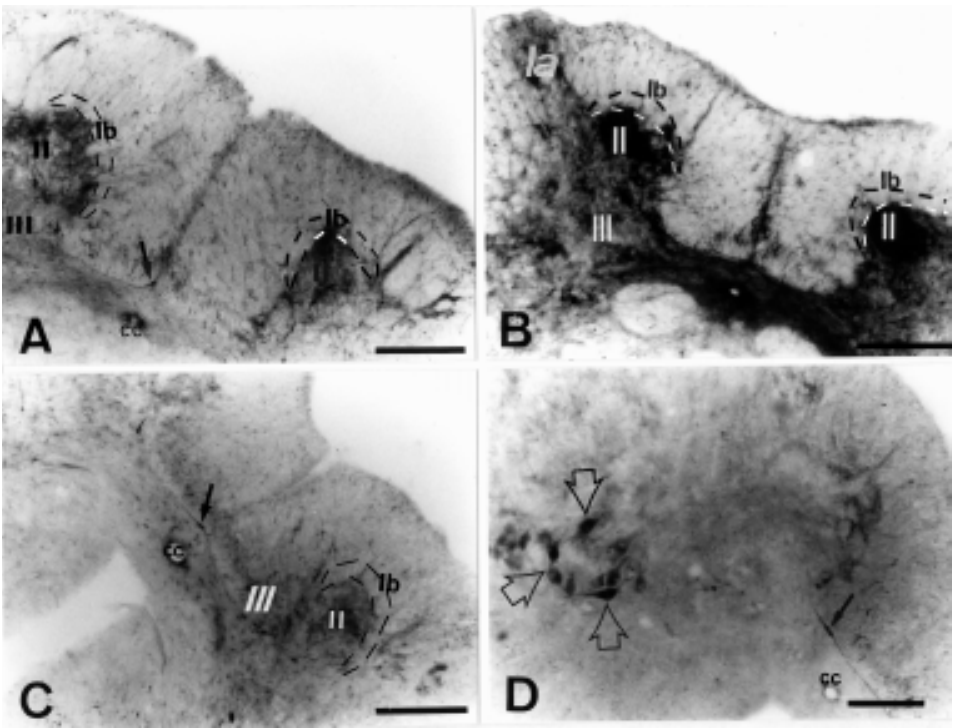
Figure 2 - NADPH-d activity in the turtle spinal cord after tran- section of the sciatic nerve. Ma- terial from an untreated turtle (A) and material obtained 15 (B) and 30 days (C) after peripheral axotomy. Open arrows in D indi- cate positive motor neurons 90 days after sciatic nerve transec- tion. Filled arrows indicate bi- tufted neurons. CC, Central ca- nal. Ia, Ib, II and III correspond to dorsal horn areas. Scale bar = 300 µm (A, B and C) and 150 µm